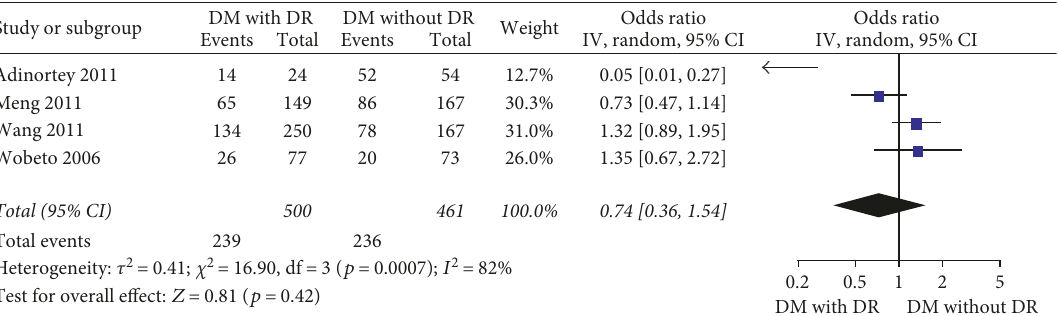
Figure 4: Forest plot for meta analysis comparing DR with DWR in recessive model (TT versus CT+CC).